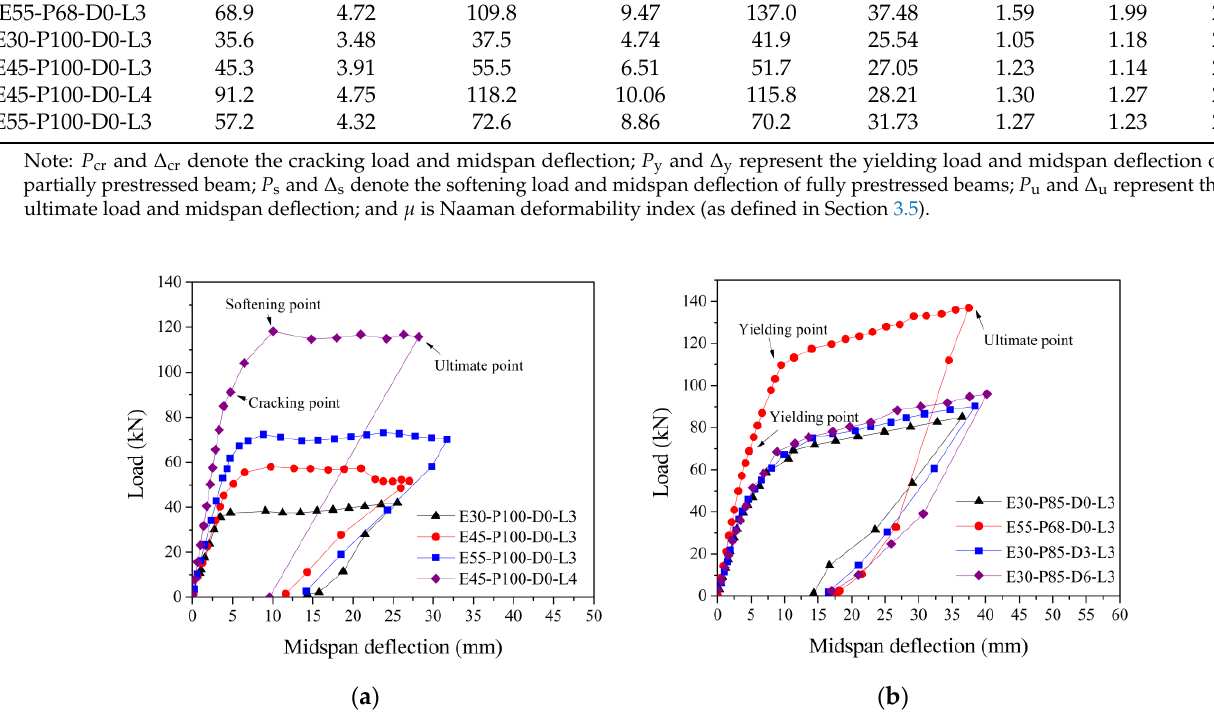
( b ) Figure 7. Moment – deflection relationships of specimens: ( a ) the fully prestressed specimens; ( b ) the partially prestressed specimens. 3.2.1. The Fully Prestressed Specimens Overall, the cracking load of the fully prestressed beam was mainly determined by the effective stress in CFRP tendons and the initial cracking strength of UHPC, whereas the ultimate load was mainly controlled by the ultimate stress in CFRP tendons and the tensile strength of UHPC. The load-deflection behavior of the fully prestressed beams could be roughly described into three stages: (1) The first stage was up to the flexural cracking point, and represented the stiffness of uncracked beam section. As the applied load increased, the flexural crack appeared at the bottom of the midspan section, where the tensile strain exceeded the cracking strain of the UHPC matrix. The cracking load corresponded to the tensile strength of UHPC matrix. Due to the steel fibers across the crack and the application of CFRP tendons, the stiffness of the fully prestressed specimen did not decrease immediately after the initial cracking state. (2) The second stage was from the flexural cracking point to the softening point. Because the crack surfaces were bridged by closely spaced steel fibers, the flexural cracks propagated sightly during this stage. However, the steel fibers at the crack region gradually exhausted their crack-bridging effect with the increasing load, and thus the softening load was obtained when the strain in the most extreme fiber in tension